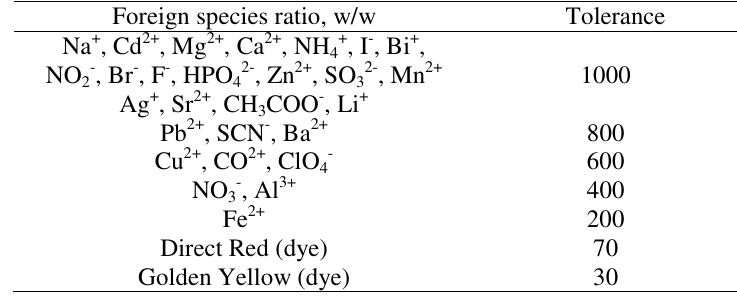
Table 2. The effect of foreign species on the determination of 20 mg L -1 of DY 12 Foreign species ratio,